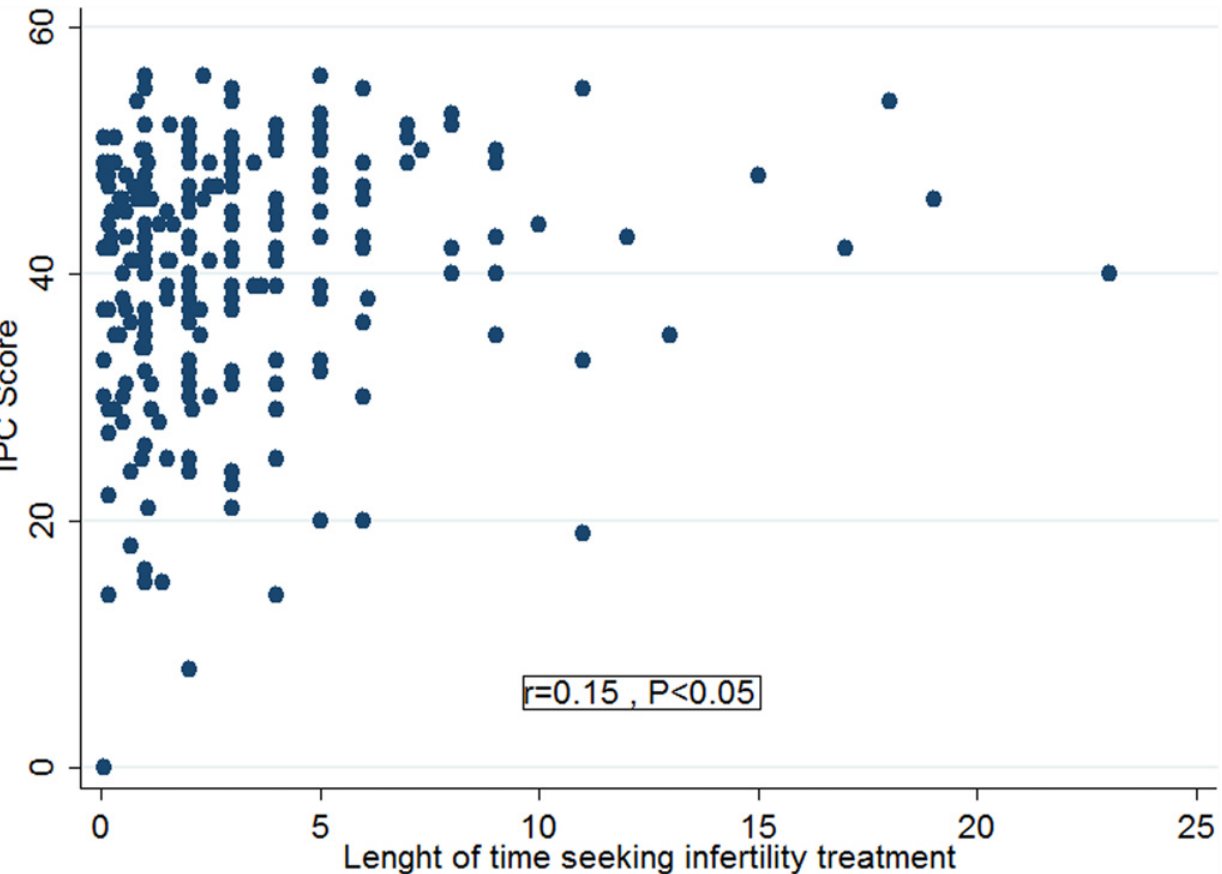
Fig 1. Scatter plot showing the correlation between the score of irrational parenthood cognitions (IPC) and the length of time seeking infertility treatment.